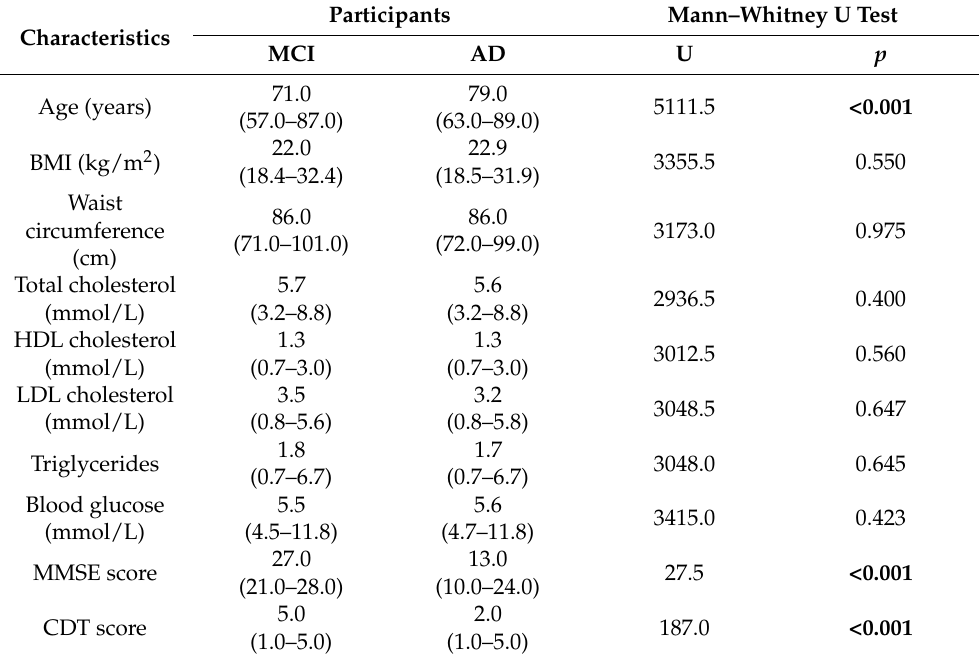
Table 2. Demographic and clinical data of subjects with MCI disorder and subjects with AD. All data are presented as median